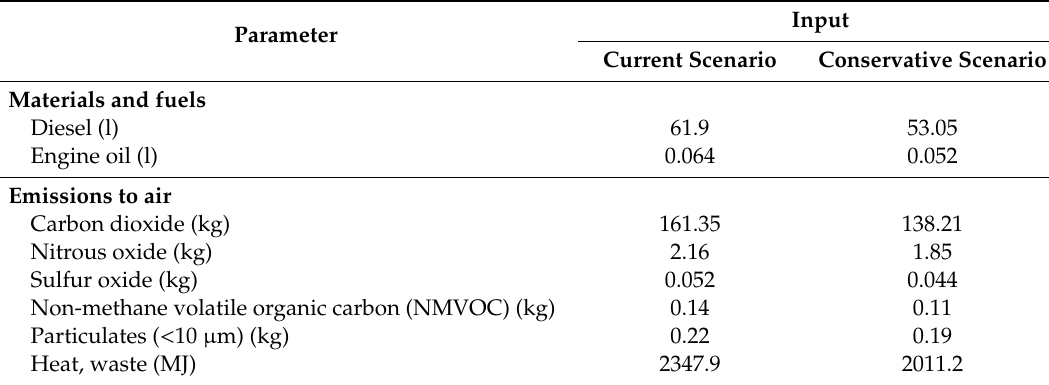
Table 1. Life cycle inventory (LCI) of canal network management in the current and conservative scenarios. All inputs are calculated for the functional unit of 1 km of